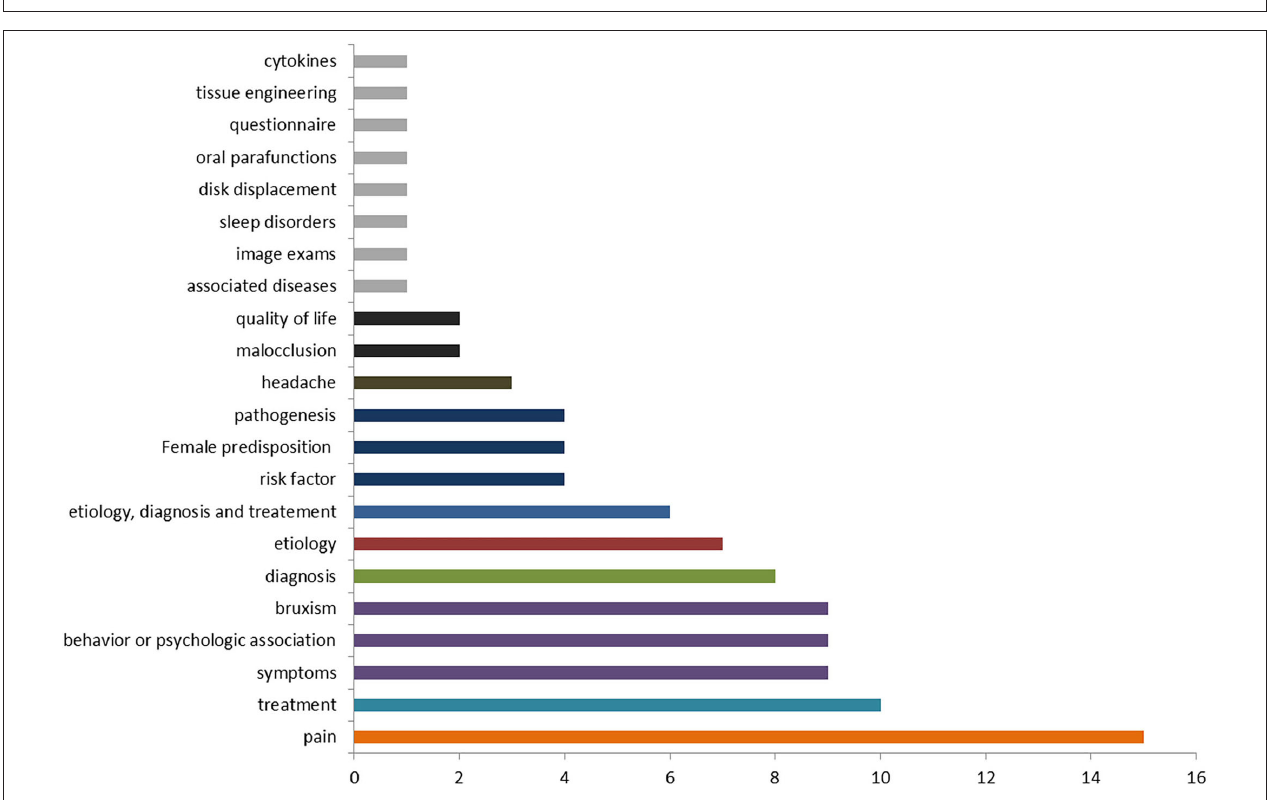
FIGURE 3 | Topics within the field of temporomandibular disorders covered in the 100 top-cited studies.